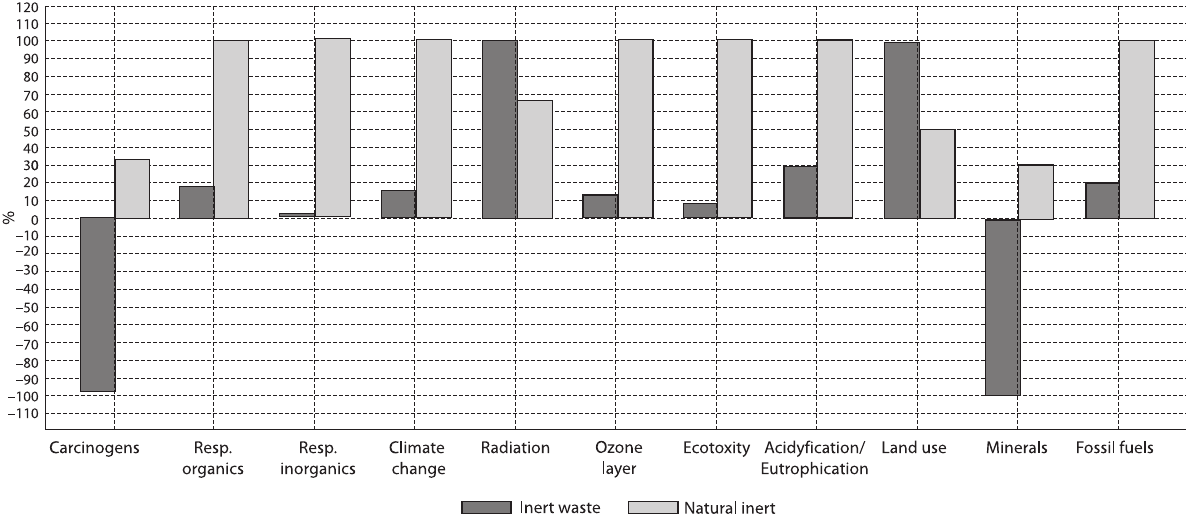
Fig. 4. Characterization of impact categories with Eco-Indicator